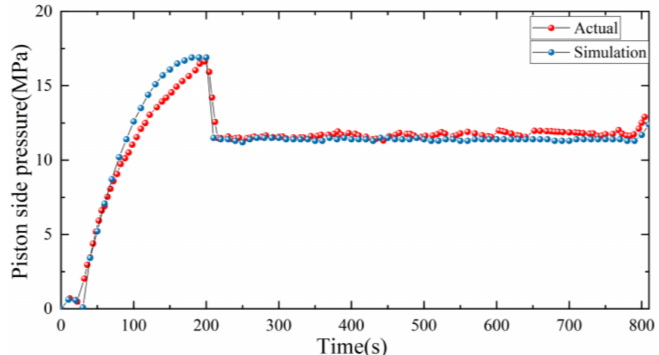
Figure 12. Piston side pressure when lifting.